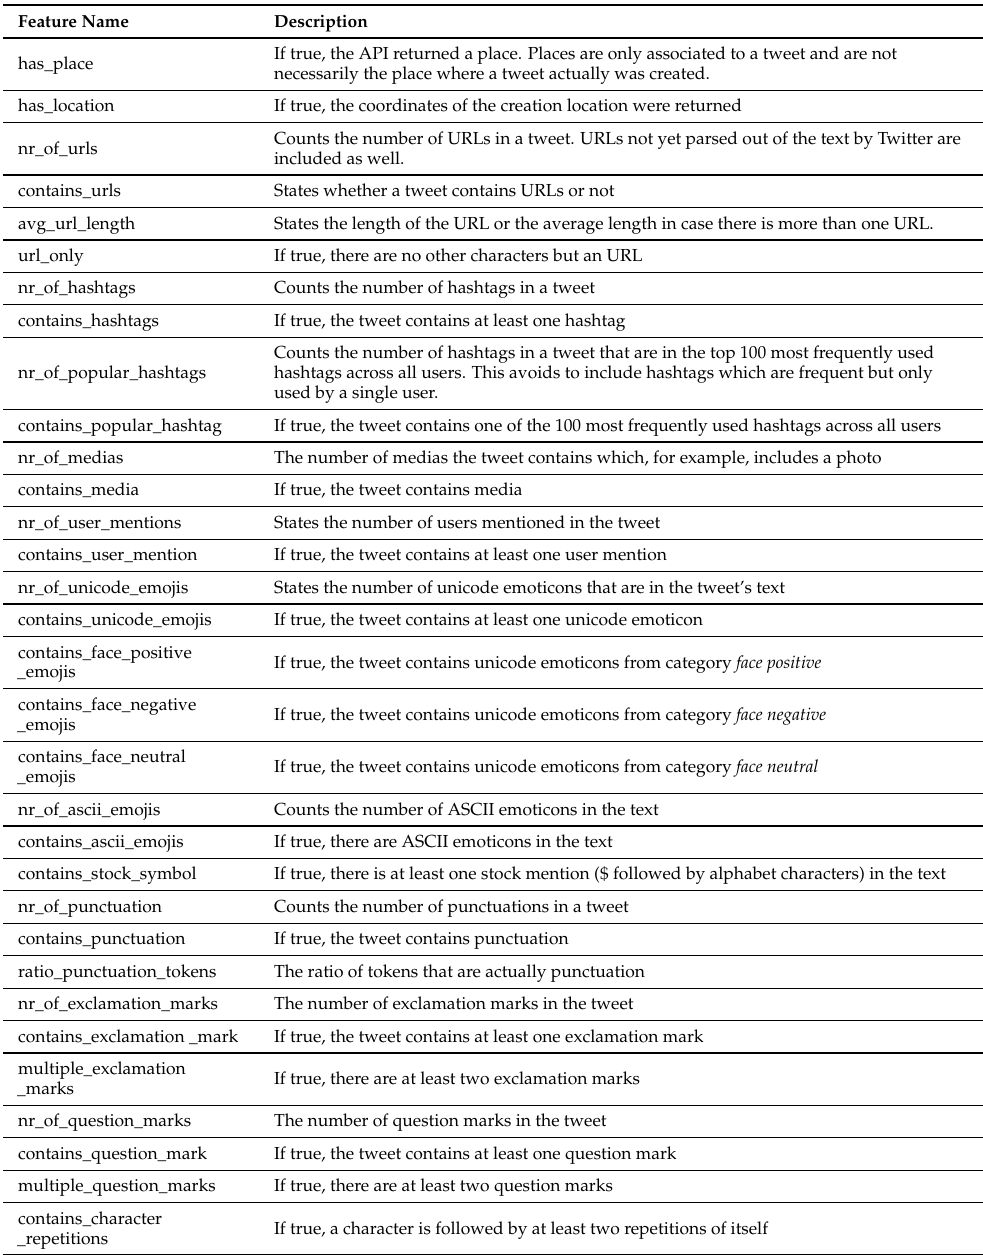
Table A4. Overview of the derived tweet level